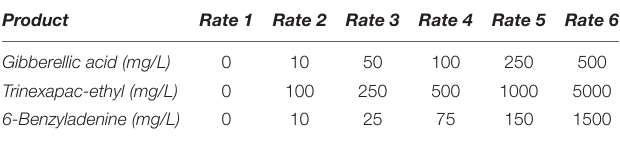
TABLE 2 | The three ‘model’ hormone products with the six rates and molecular concentrations selected to generate a concentration response curve.